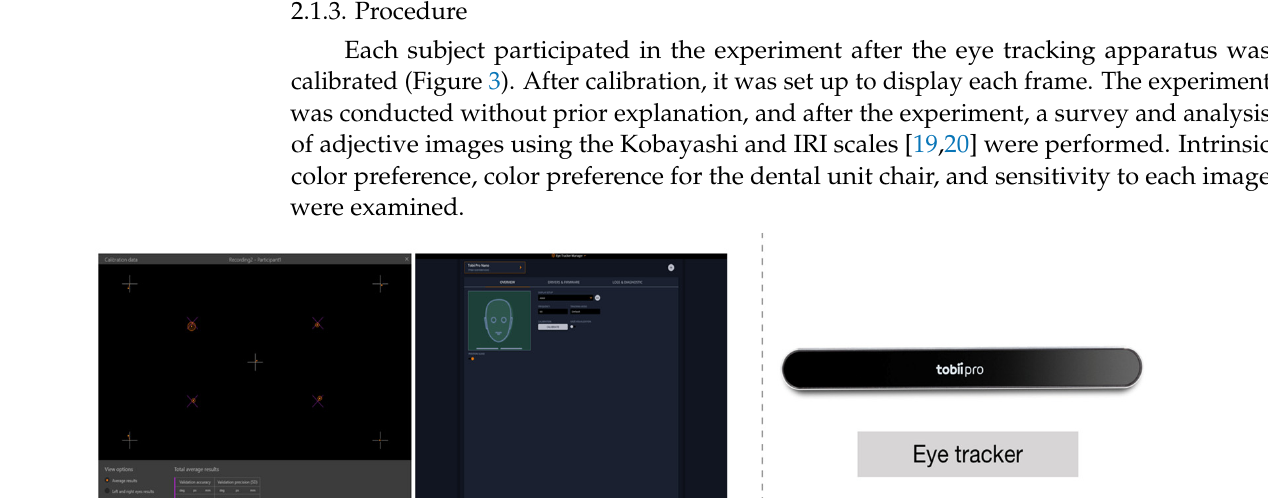
Table 1. Previous literature on gaze